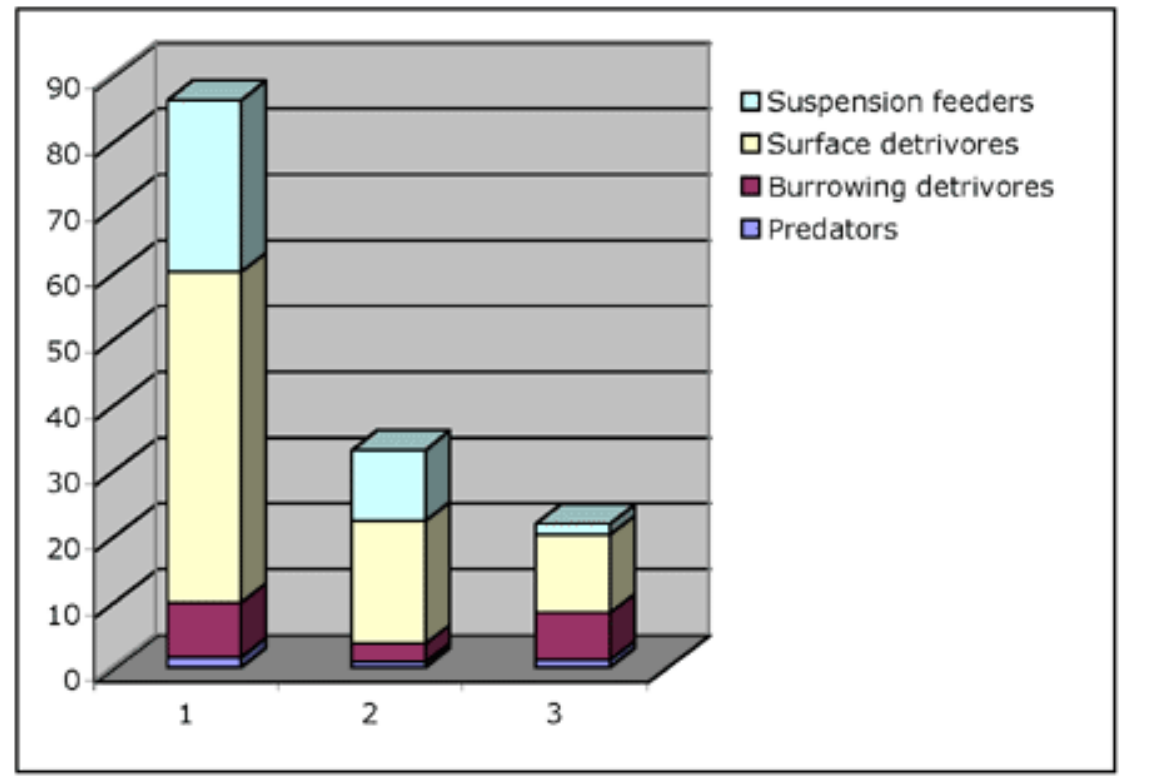
Fig. 1 . Shift in species composition in response to cover by algal mats, illustrated by altered infaunal diversity (individuals per 0.01 m 2 ) in different functional groups . Treatment 1 = no algal mats; Treatment 2 = 480 g m -2 of algae in net bags placed somewhat above the sediment; Treatment 3 = 480 g m -2 of algae in cages on the sediment. Treatment 2 simulates moderate algae cover as water exchange is facilitated. (ANOVA; p < 0.01) (based on Österling and Pihl